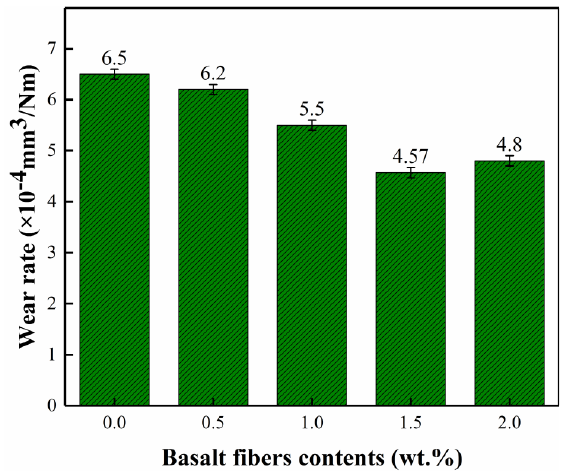
Figure 9. Wear volume of composites with different basalt fiber contents.